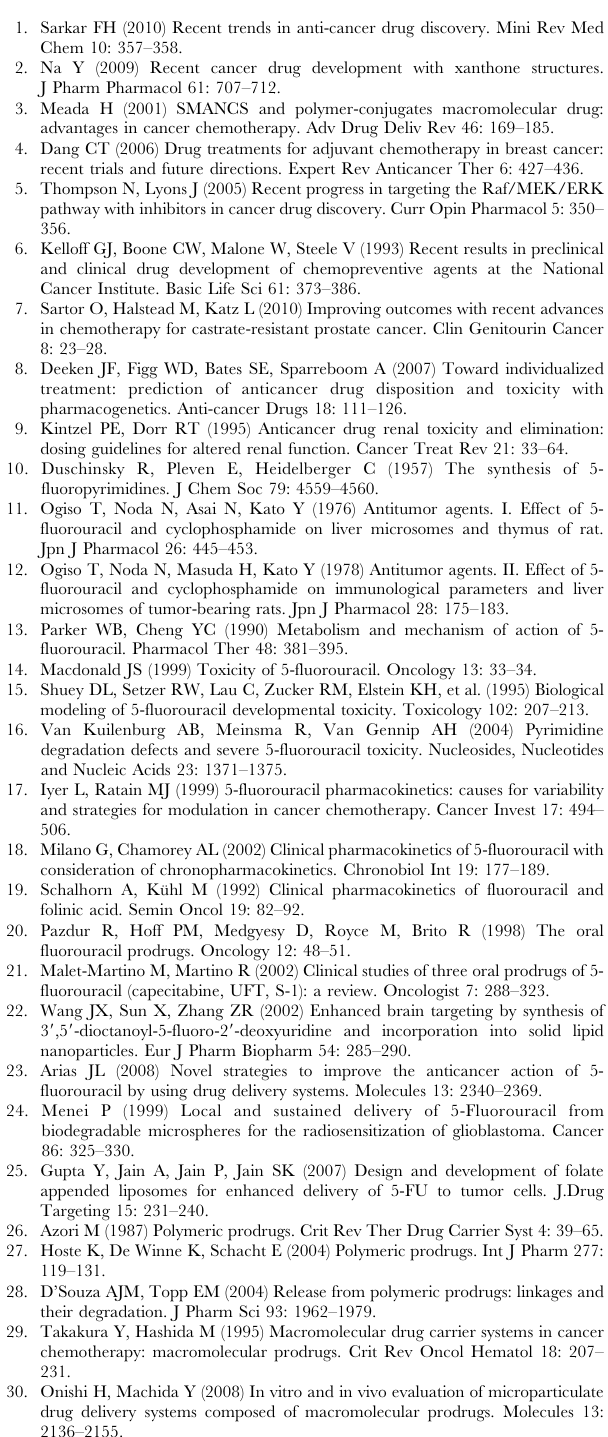
File S1 Supporting files. Figure S1 , Identification